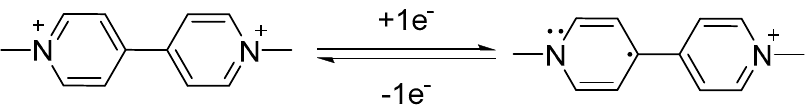
Scheme 2. Schematic diagram of PQ’s reaction process.